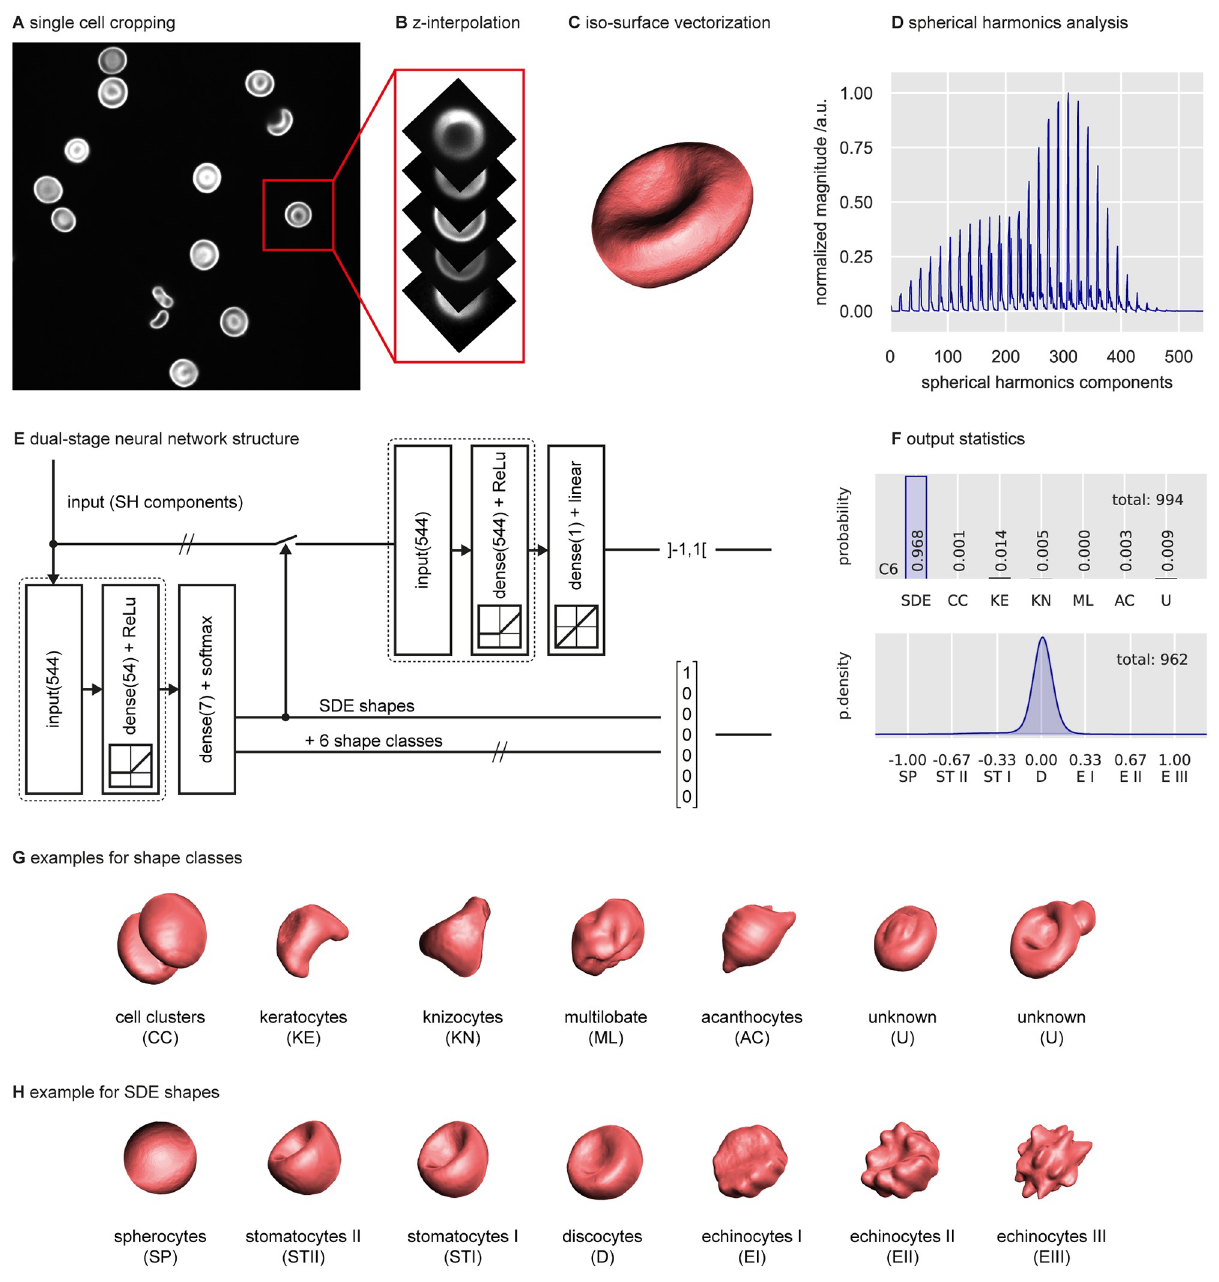
Fig 1. Workflow for automatic classification by the dual-stage ANN. (A) After sample staining and imaging by confocal microscopy, each cell is cropped individually and the full stack is interpolated in the z direction to achieve isotropic resolution (B). (C) The isosurface is retrieved by applying a constant threshold to each cell. (D) The vectorized data are transformed with respect to their spherical harmonics ( L 2 -norm of 32 radii and corresponding 16 frequencies, see Materials and methods), representing a rotation invariant form of the cell shape. (E) Data are fed to the dual-stage ANN, with the first-stage resulting in a classification output (bottom). This stage consists of a three-layer architecture providing an input layer (544 neurons), a fully connected hidden layer with a ReLU activation function (54 neurons) and a fully connected output layer (softmax activation). The output is represented by a vector of size 7, which is subjected to discrimination by a given threshold. If the confidence is higher than 75% (threshold), the output is assigned to a certain existing class. Otherwise, the output is assigned to unknown (U) shapes. All detected SDE shapes are forwarded to the second-stage ANN, with an anatomy similar to that of the first ANN, except for the hidden layer that exhibits 544 neurons. The regression-type output layer assigns each cell a score between − 1 and +1 and allocates them on the continuous SDE scale (top). (F) Example of a typical resulting shape distribution in a healthy subject. Almost all RBCs are discocytes. (G) Representative images for 6 mutually exclusive shape classes (see Materials and methods for description): two out of many different examples of “unknown” shapes are shown. (H) Representative cells of the SDE scale. The training data included SDE shapes artificially induced by changing the osmolality of the suspension